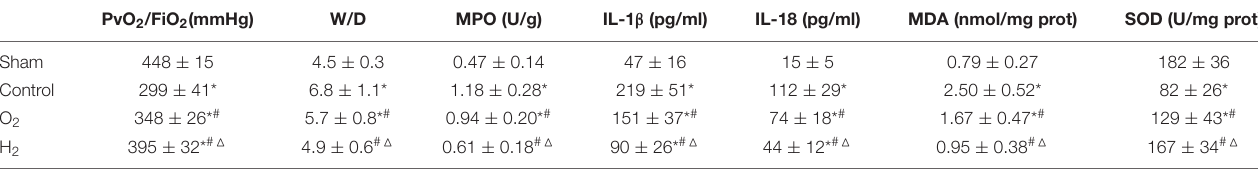
TABLE 1 | PvO 2 /FiO 2 and the indices of the inflammatory response and oxidative stress in each group (mean ± SD, n = 8). PvO 2 /FiO 2